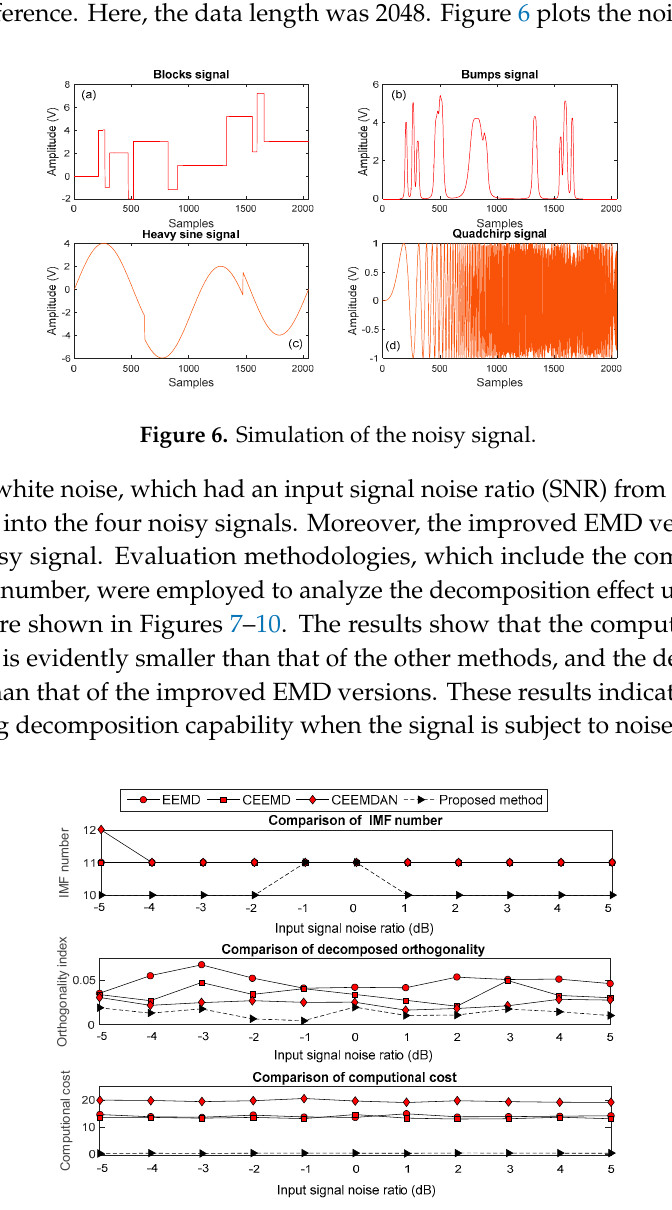
Figure 8. Comparison of the decomposition effect for the ‘bumps’ signal. Figure 9. Comparison of the decomposition effect for the ‘heavy sine wave’ signal.